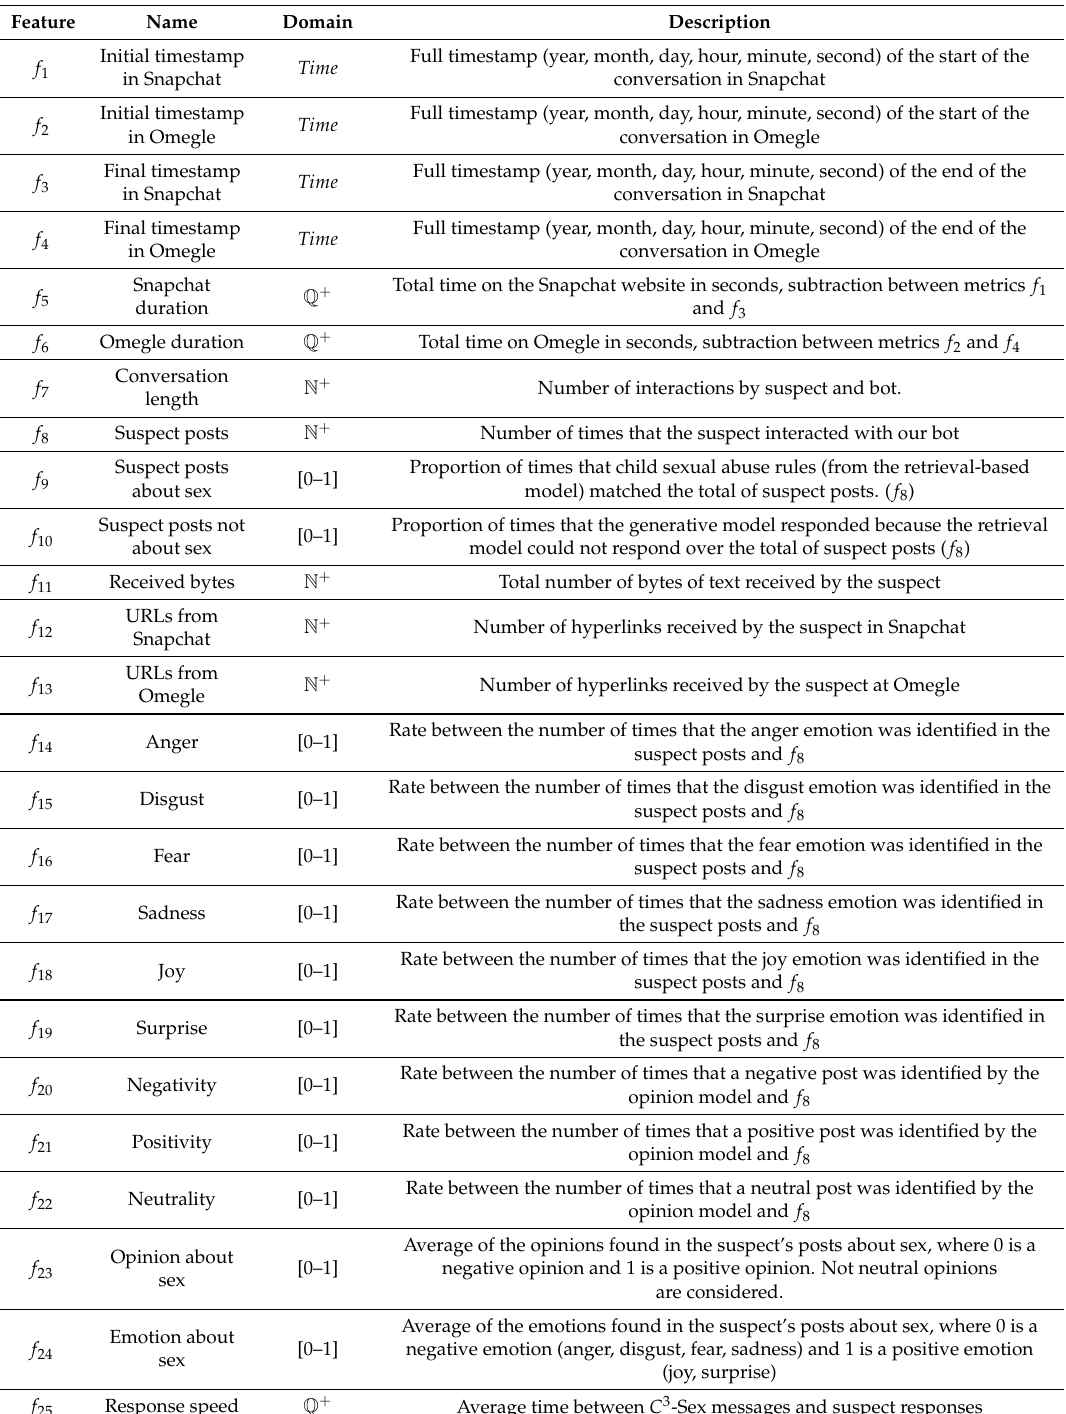
Table 4. Suspect profiling